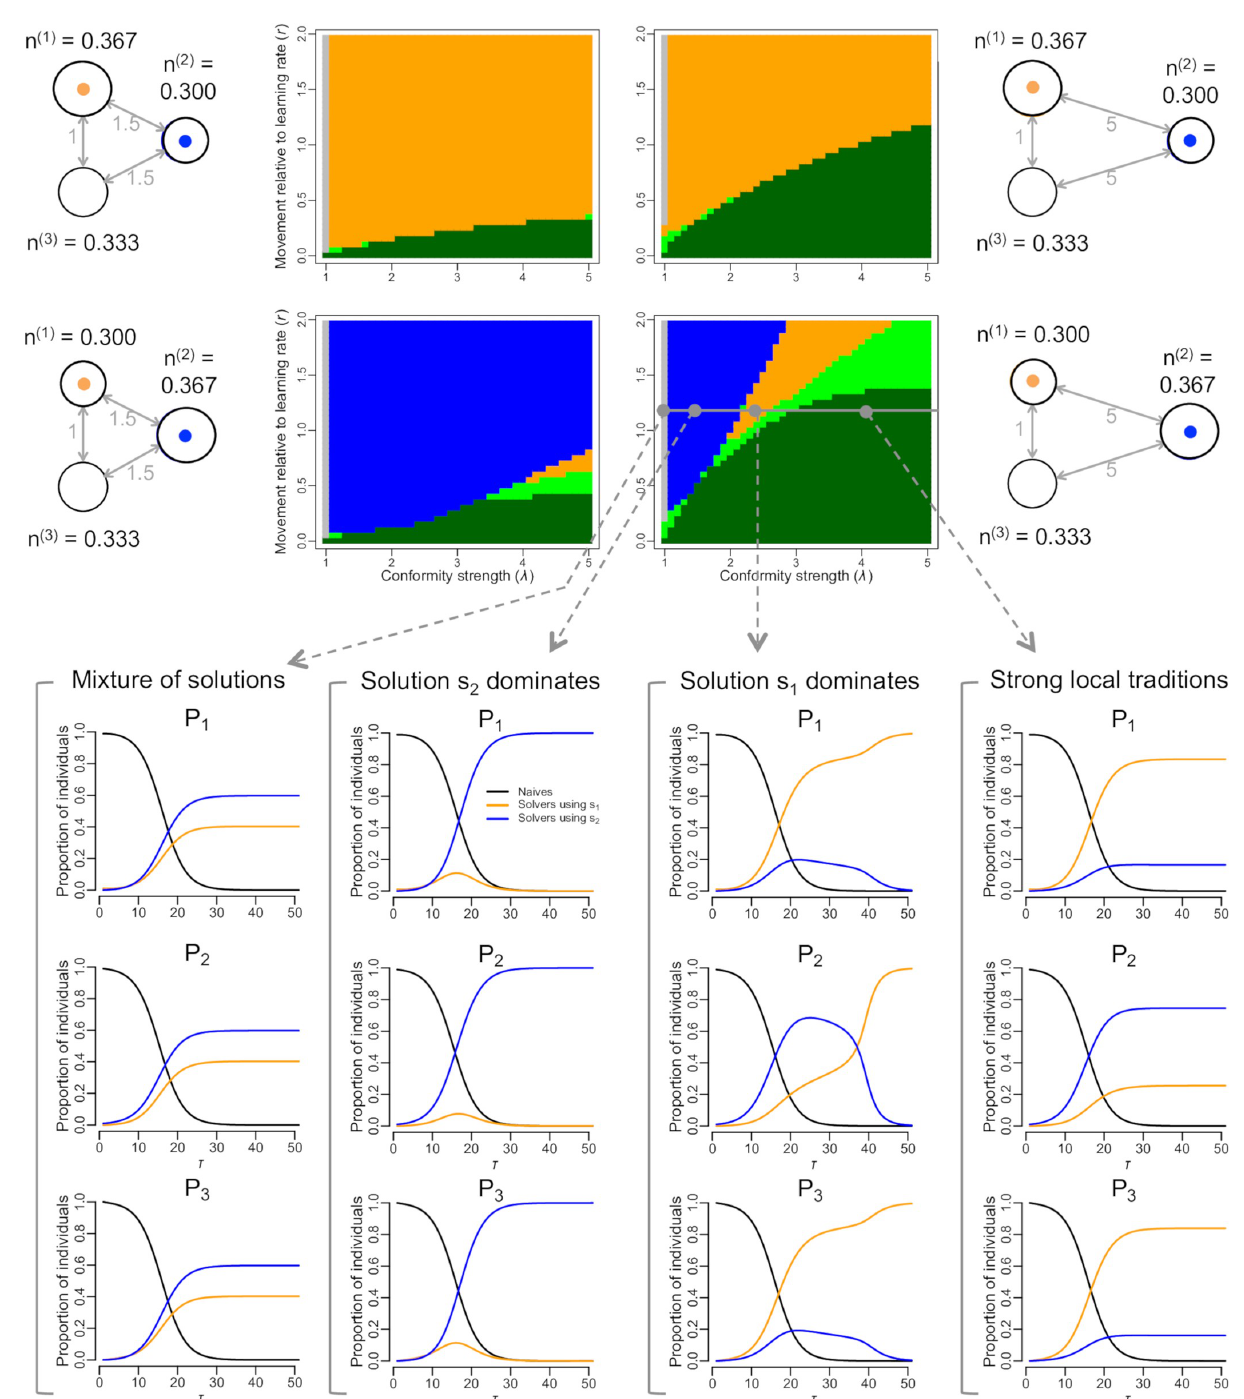
Fig 2. Spatial configuration of sub-populations has a complex effect on how conformity and movement lead to either the emergence of local traditions or the domination of a single solution. This figure shows the model outputs in the three-sub-population case. At the start of every simulation, sub-population P 1 contained innovators using solution s 1 (1% of its population), sub-population P 2 contained innovators using solution s 2 (also 1% of its population), and sub-population P 3 contained only na ï ve individuals. Each pixel in the phase diagrams corresponds to a simulation run with the corresponding parameter values, and the colour of the pixel indicates the emerging pattern after 150 days: grey = mixture of solutions in every sub-population, blue = solution s 2 dominated the whole system, orange = solution s 1 dominated the whole system, light green = weak local traditions, dark green = strong local traditions. The two columns of phase diagrams represent different spatial configurations; that is different distances between sub-population 2 and the other two sub-populations (whose distance separating them was set to 1), generating different movement rates between pairs